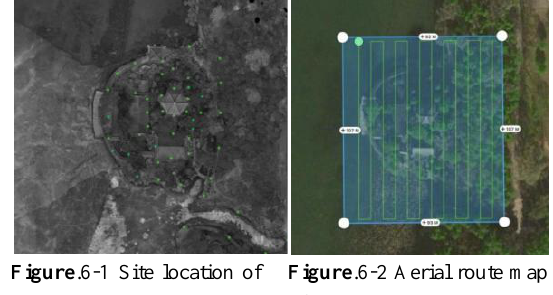
Figure .6-1 Site location of Figure .6-2 Aerial route map